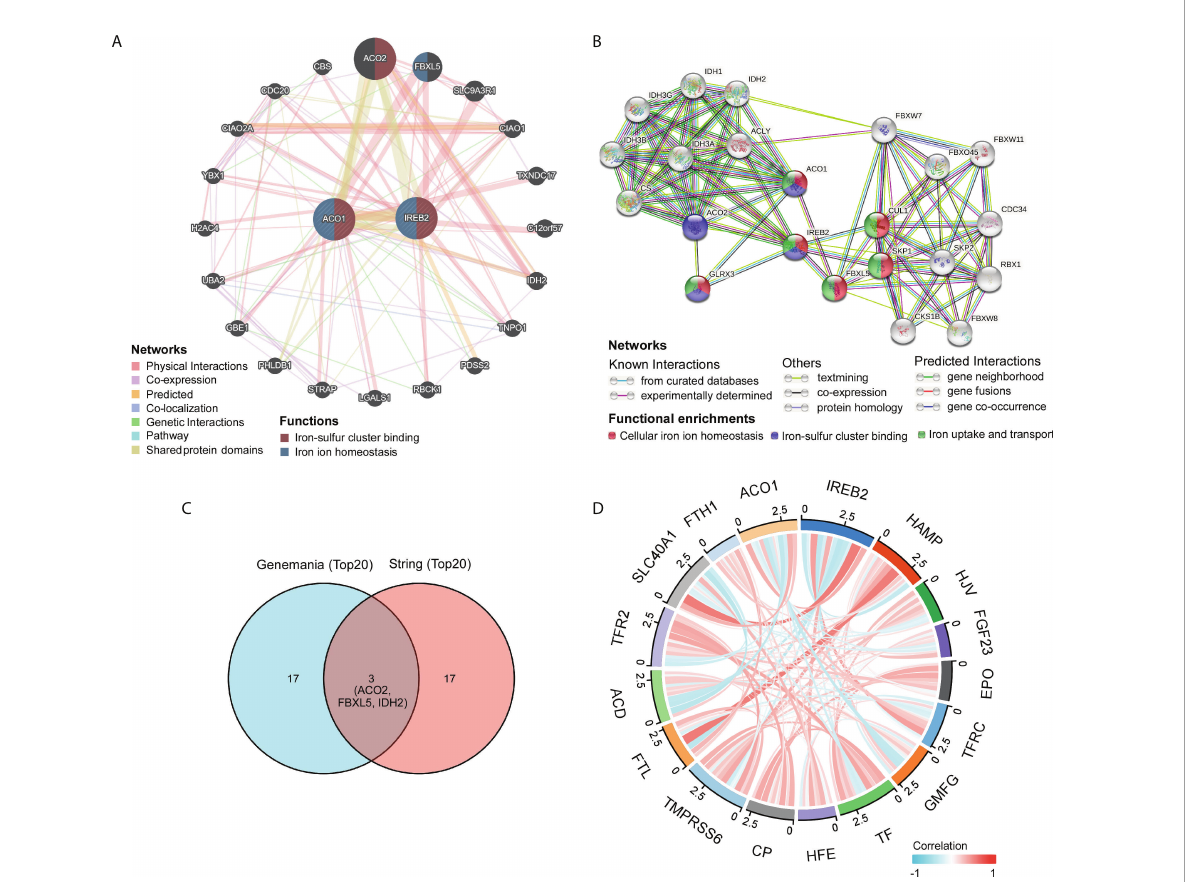
FIGURE 5 Identi fi cation of ACO1- and IREB2-interacting genes and proteins. (A) The gene – gene interaction network of ACO1 and IREB2 was constructed using GeneMania. (B) The protein – protein interaction (PPI) network of ACO1 and IREB2 was generated using STRING. (C) A Venn diagram showing the overlap of top 20 genes and proteins predicted by GeneMania and STRING. (D) A chord diagram shows the correlations between ACO1, IREB2 and iron metabolism – related genes in